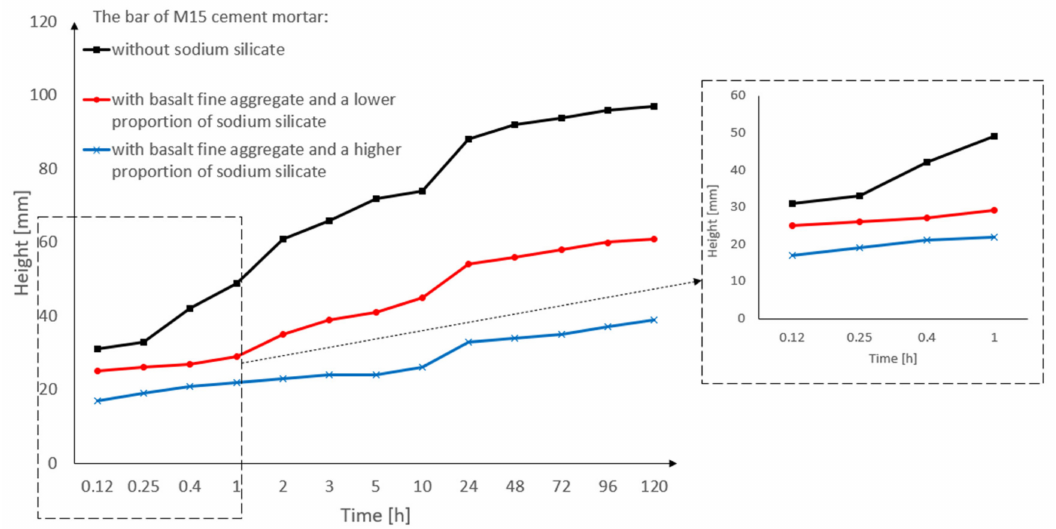
Figure 12. Capillary suction of the M15 cement mortar bar with basalt fine aggregate: without sodium silicate, with a lower proportion of sodium silicate, and with a higher proportion of sodium